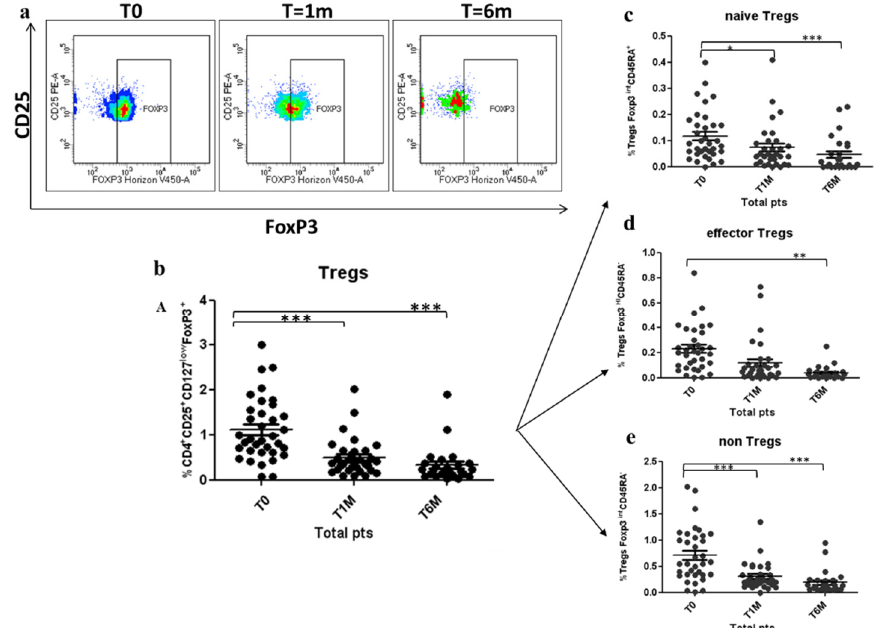
Figure 4. Reduction of Treg cells and Tregs subpopulation during Octreotide LAR treatment: ( a ) Representative sample analysed by flow cytometry, showing the reduction of circulating Tregs in a patient after 1 and 6 months of treatment. ( b – e ) Decrease of peripheral Tregs, naïve Tregs, effector Tregs and non-Tregs after 1 month (T1M) and 6 months (T6M) of treatment with Octreotide Lar. Tregs are expressed as percentage of T cells CD4+CD25+CD127lowFoxP3+ ( b ); naïve Tregs are expressed as percentage of Tregs CD127lowFoxP3intCD45RA+ ( c ); effector Tregs are expressed as percentage of CD127lowFoxP3hiCD45RA- Tregs ( d ); and non-Tregs are expressed as percentage of CD4+CD25+CD127lowFoxP3intCD45RA-. * p < 0.05; ** p < 0.005; *** p < 0.0005.